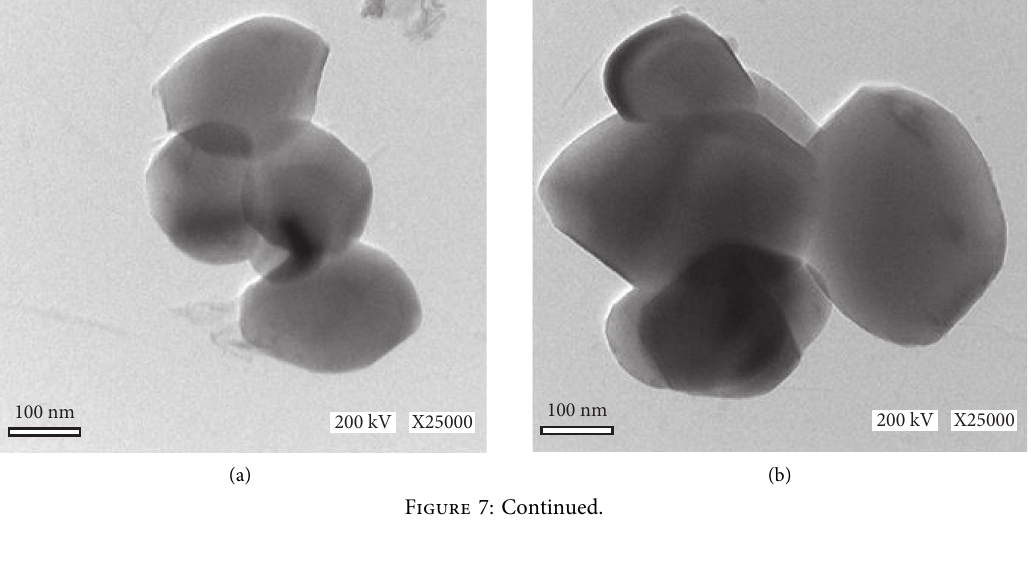
2 , (c) CaTiO 3 obtained after calcination at 900